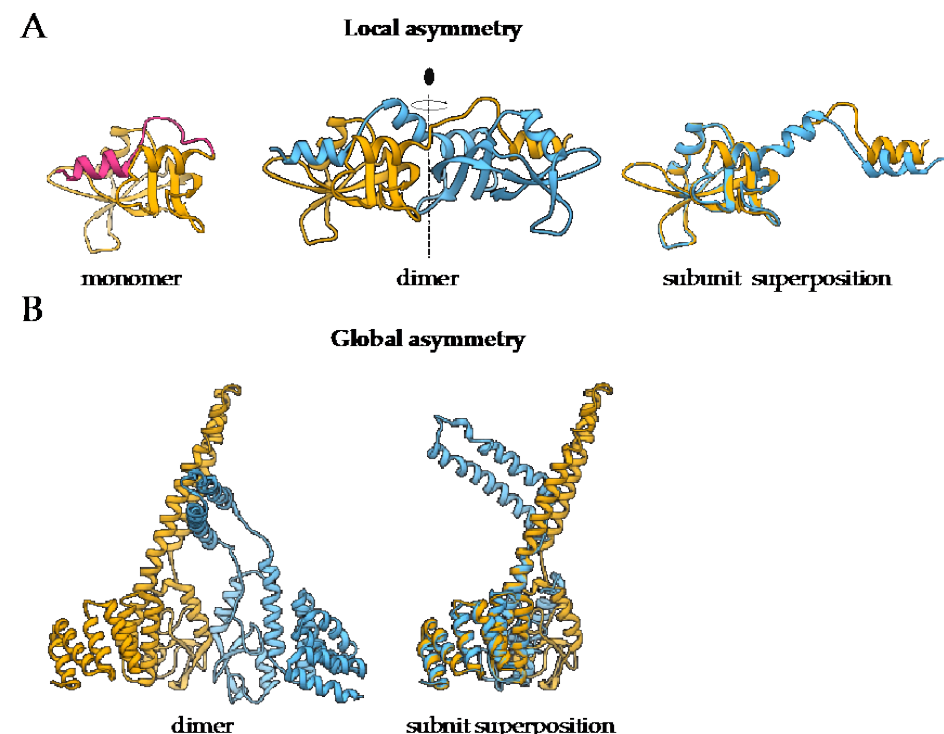
Figure 1. The difference between local and global asymmetry. ( A ) An example of a globally symmetric homo-oligomeric complex with a substantial local asymmetry is the structure of bovine pancreatic ribonuclease N-term-swapped dimer (PDB: 1A2W) [24,32]. During the dimer formation, the N- terminal region of the monomer (PDB: 1A5P, pink) [33] is swapped the juxtaposed subunit. ( B ) Murine CHIP-U-box E3 ubiquitin ligase (PDB: 2C2L) [34] is an example of a globally asymmetric homo- oligomeric complex. Individual subunits are depicted in yellow and blue. For both complexes, the superposition of polypeptide chains is also presented to demonstrate the extent of structural differences between the subunits.